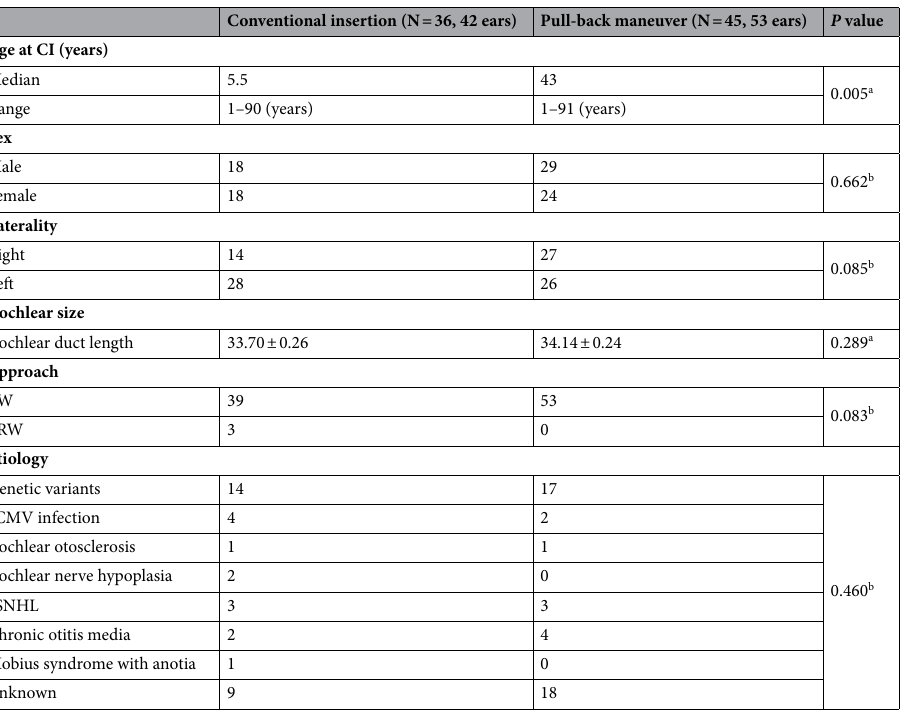
Table 1. Demographics and clinical characteristics. The data are presented mean ± SEM. Abbreviation: N number, CI cochlear implantation, SEM standard error of mean, RW round window, ERW extended round window, cCMV congenital cytomegalovirus, SSNHL sudden sensorineural hearing loss. a That comparison of age at CI and cochlear duct length between two groups was based on the Mann Whitney U test due to non- standardized normality. b That comparison of sex, laterality, electrode type, approach, and etiology between two groups was based on the Chi-square test and Fischer’s Exact test, as appropriate.